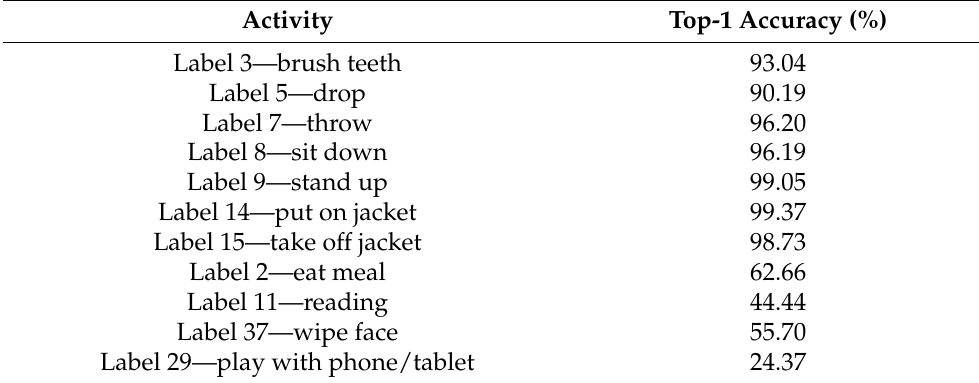
Table 11. Top-1 Accuracy GMM 9 clusters with majority for few examples from NTU-RGB+D